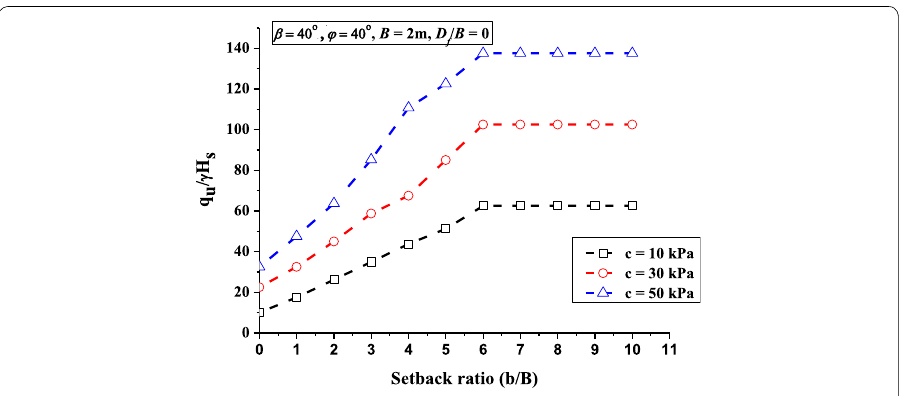
Fig. 9 Typical variation of q u / γH s with cohesion ( c ) and setback ratio ( b/B